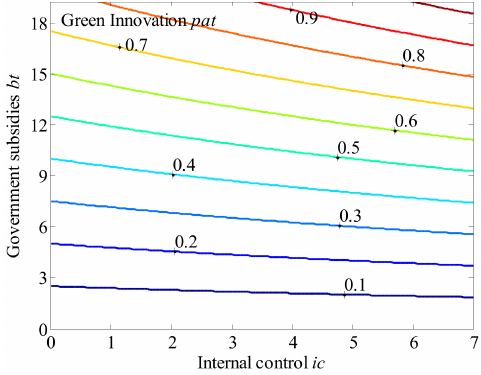
Figure 7. Regulatory effect of government